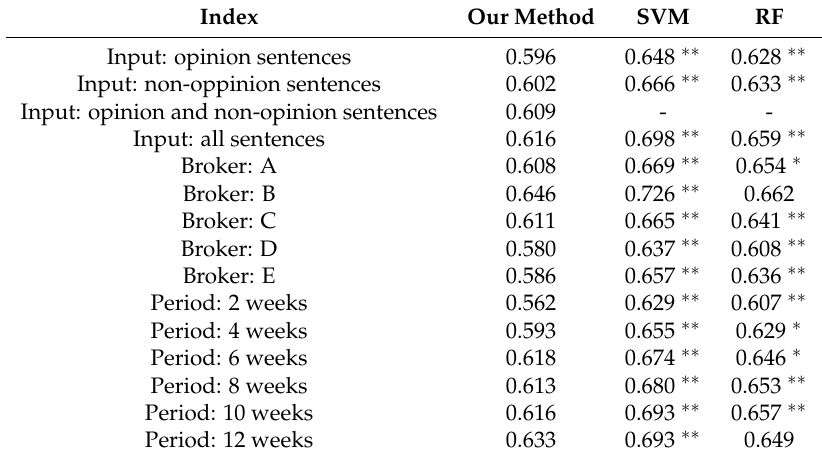
Table 9. Summary of forecasting volatilities. Macro-F1 is a measure. The scores of SVM and RF in the row of input: opinion and non-opinion sentences are indicated by hyphens (-) because SVM and RF cannot have separate inputs of opinion and non-opinion sentences.